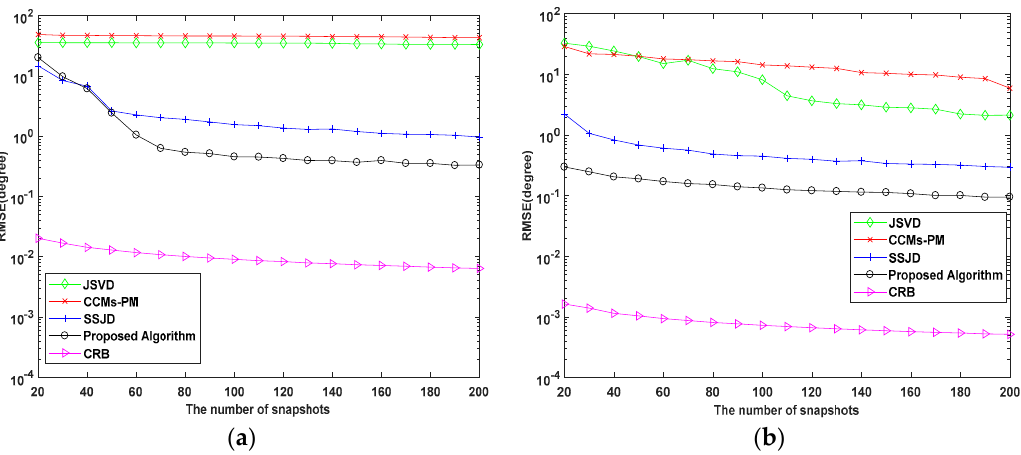
Figure 8. RMSE performance versus the number of snapshots for ( a ) SNR = 0 dB; ( b ) SNR = 10 dB.